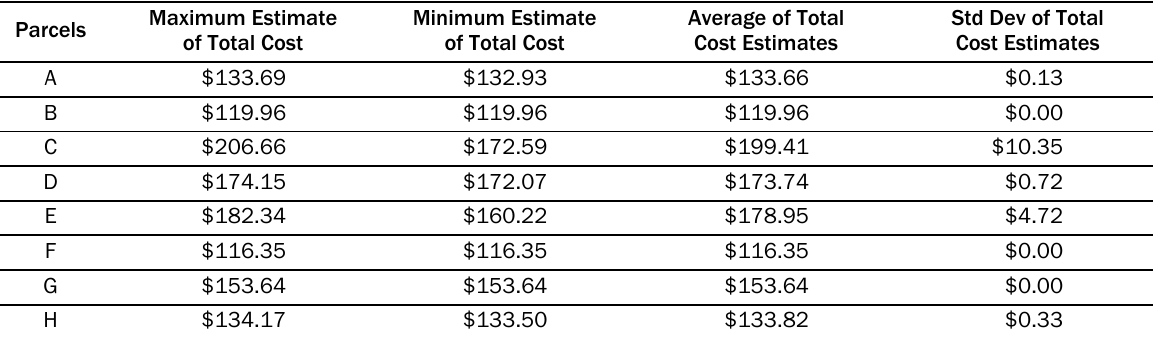
Table 3. Analysis of variation in heuristic algorithm solutions for an objective function of the minimum total cost of the USDA Thrifty Food Plan for selected residential parcels in the Gulf Coast Counties of Mississippi during spring 2011, considering both the cost of the food items and the cost of transportation to acquire them (all in US$).